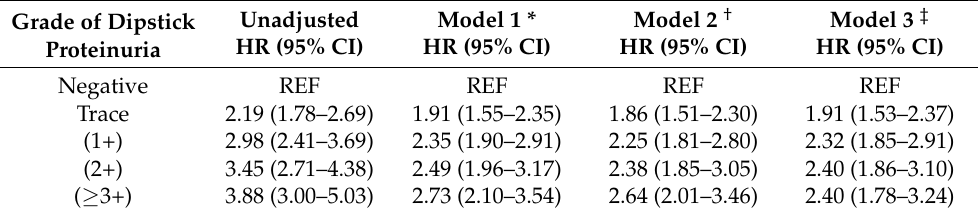
Table 3. Hazard ratios for mortality according to dipstick proteinuria among patients with hyper- tensive crisis.